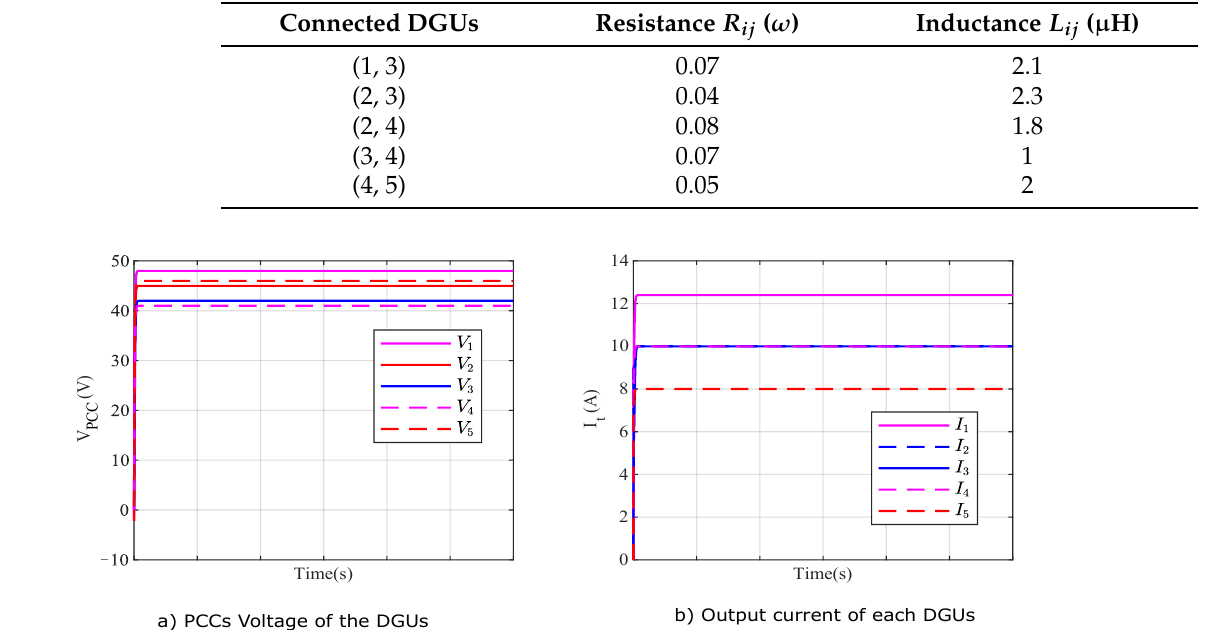
Figure 4. Primary controller output of each DGU. ( a ) PCCs Voltage of the DGUs; ( b ) Output current of each DGUs.